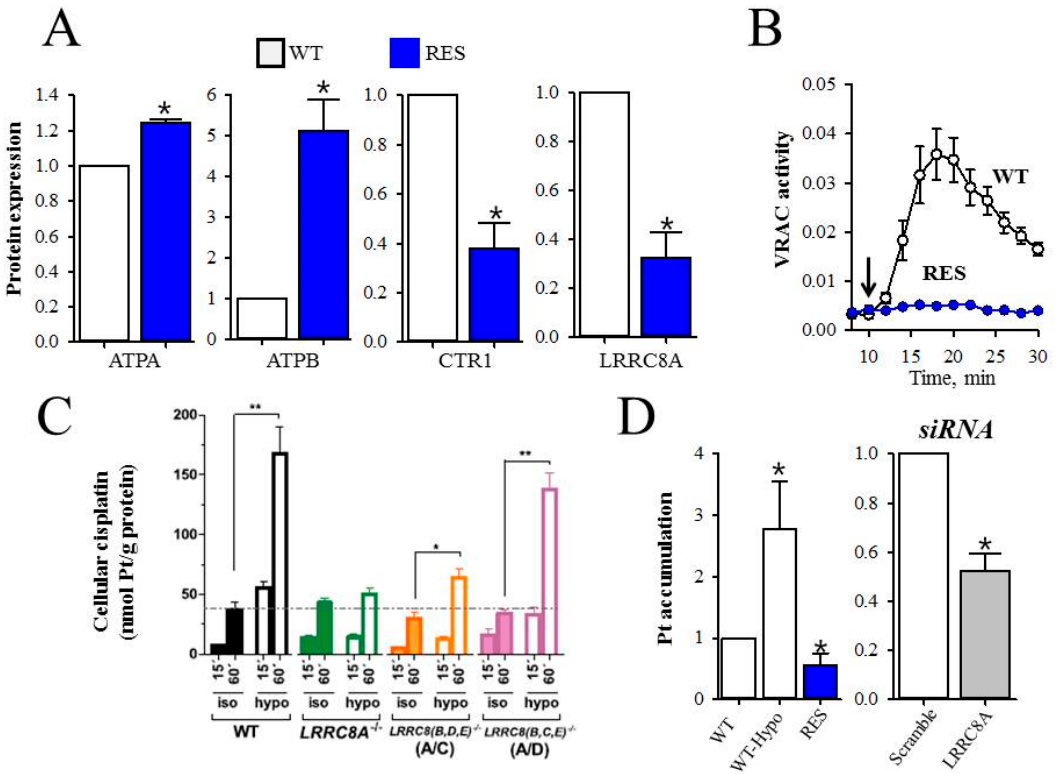
Figure 2. Acquired cisplatin resistance correlates with reduced VRAC activity and Pt accumulation. ( A ) Protein expression in cisplatin-sensitive (WT) and cisplatin-resistant (RES) A2780 cells was determined by SDS-PAGE/Western blot techniques. Protein expressions, initially determined relative to a house holding protein, are given relative to values from WT cells. * indicates a significant difference from WT cells. Adapted from [27]; ( B ) VRAC activity in WT and RES cells was determined by the tracer technique using [ 3 H]taurine. Release of taurine is shown as the fractional rate constant (min -1 ), measured under isotonic (300 mOsm; 8–10 min) and hypotonic (200 mOsm; 10–30 min) conditions. Arrow indicates time of hypotonic challenge. Adapted from [38]; ( C ) Cellular cisplatin uptake in HEK cells following short-term hypotonic and isotonic exposure in the presence of 200 µ M cisplatin. Cisplatin content was estimated as the total Pt-signal (ICP-MS) in cellular pellets. * and ** indicate significantly increased by hypotonic challenge (* p < 0.05; ** p < 0.01) Reproduced with permission from [40]; and ( D ) Pt accumulation in A2780 cells. Cellular Pt content (ng per mg protein) was determined by ICP-MS following 4 h exposure to 10 µ M cisplatin in WT under isotonic and hypotonic conditions, in RES under isotonic conditions, and in WT cells treated with scramble siRNA (control for the siRNA technique) or LRRC8A siRNA. Adapted from [27]. * indicates a significant difference from WT cells and scramble siRNA.